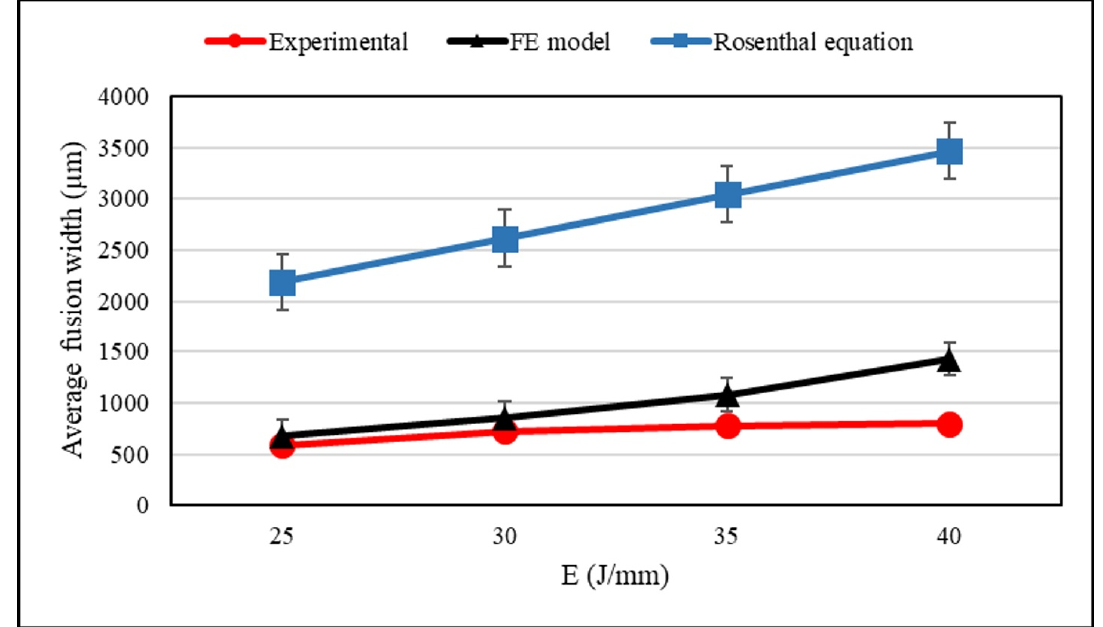
Figure 5. Comparison of the fusion width obtained from experiments, the numerical modeling, and the analytical Rosenthal equation.